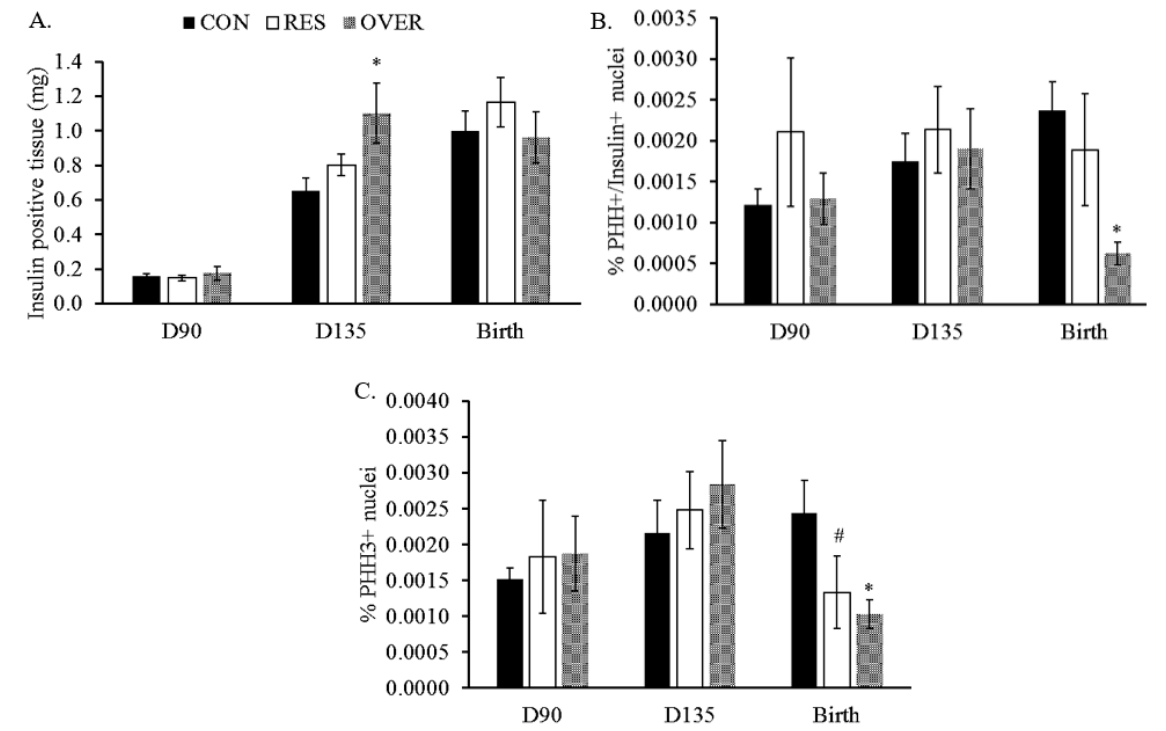
Figure 2. Maternal over-nutrition increases insulin positive area in the pancreas of fetuses at d 135 of gestation and reduces cellular proliferation at birth. Insulin positive area ( A ), percent PHH3/Insulin positive nuclei ( B ) and PHH3 positive nuclei ( C ) were quantified and false colored using ImageJ. Data were normalized using the mass of the pancreas or total number of nuclei where applicable. * p ≤ 0.05, # 0.05 < p ≤ 0.10 compared with CON.